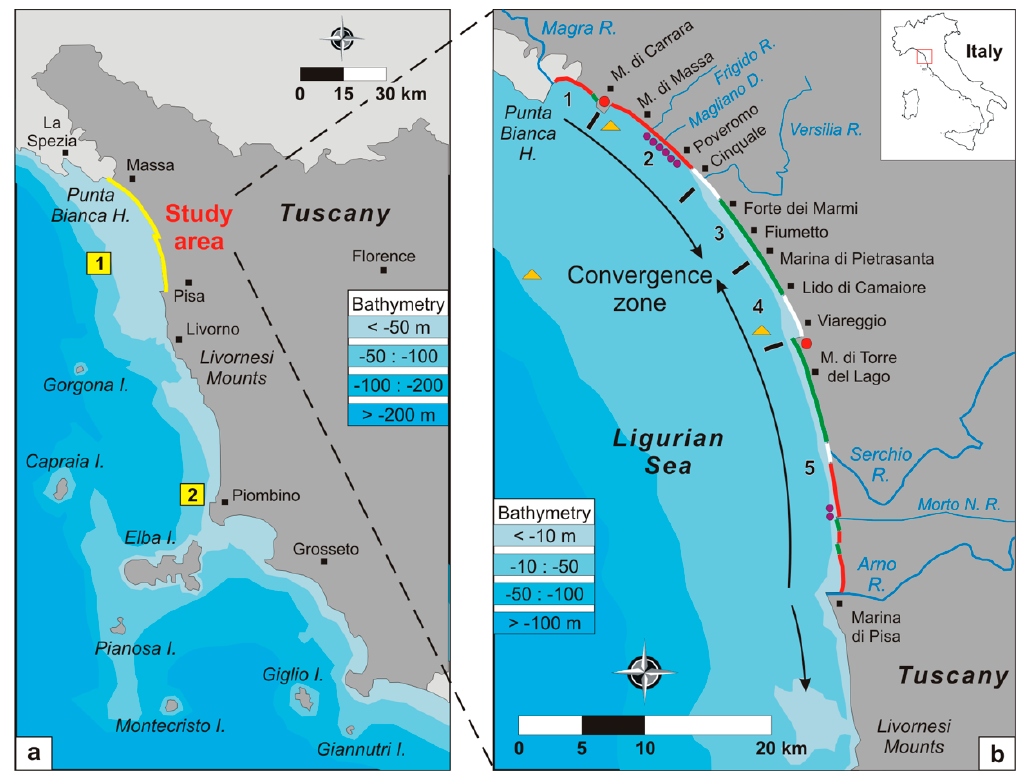
Figure 1. Map of the study area. ( a ) the Tuscany coast, with the indication of the study area (yellow line) and the location of the two continental shelf relict sand reservoirs (yellow squares: 1: Massa; 2: Piombino); ( b ) zoom-in of the study area: green and red lines indicate accretion and erosion areas respectively; the sites characterized by equilibrium are indicated with white lines; the red dots represent the location of the ports of Marina di Carrara and Viareggio; the yellow triangles point out the approximate locations of the offshore dumping sites; the purple dots represent the borrow sites of shoreface dredging; the black numbers correspond to the 5 sub-cells in which the main littoral cell has been subdivided; the black arrows point out the direction of the littoral drifts.